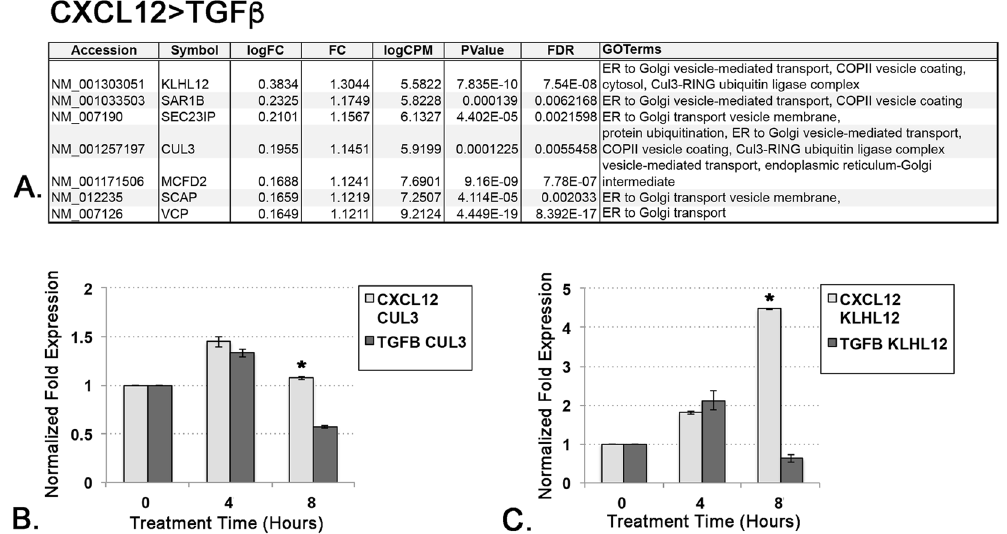
Figure 3. CXCL12-Treated Cells Demonstrate Significant Up-Regulation of Transcripts Encoding COPII Vesicle Proteins. ( A ) Table of GO terms associated with specific genes encoding proteins that function in ER to Golgi transport that were significantly up-regulated by CXCL12, but not TGF β , treatment. All of these genes encode proteins that comprise multi-subunit RING-finger type 3 Cullin-RBX E3 structures which, upon the addition of KLHL12, forms COPII vesicles essential for procollagen secretion. The gene Accession numbers and Symbols are as indicated. LogFC (log fold change) and FC (fold change) refer to CXCL12 > TGF β after normalization to vehicle; logCPM = log counts per million; FDR = false discovery rate. ( B , C ) Graphs demonstrating averages of triplicate measures of normalized (to vehicle) fold expression of CUL3 ( B ) and KLHL12 ( C ) in CXCL12- or TGF β -treated cells by qRT-PCR analysis confirm that both genes were more robustly transcriptionally induced by CXCL12 than TGF β , particularly at 8 hours treatment ( * p <